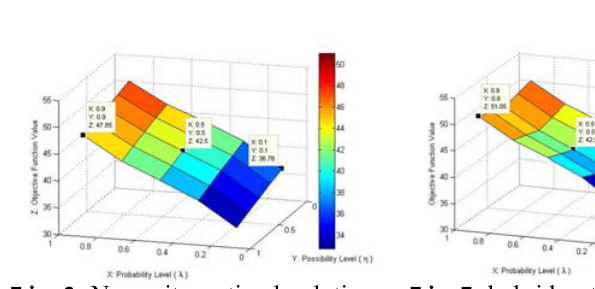
Fig. 5. Possibility optimal solutions for lowest, middle and highest levels of , 